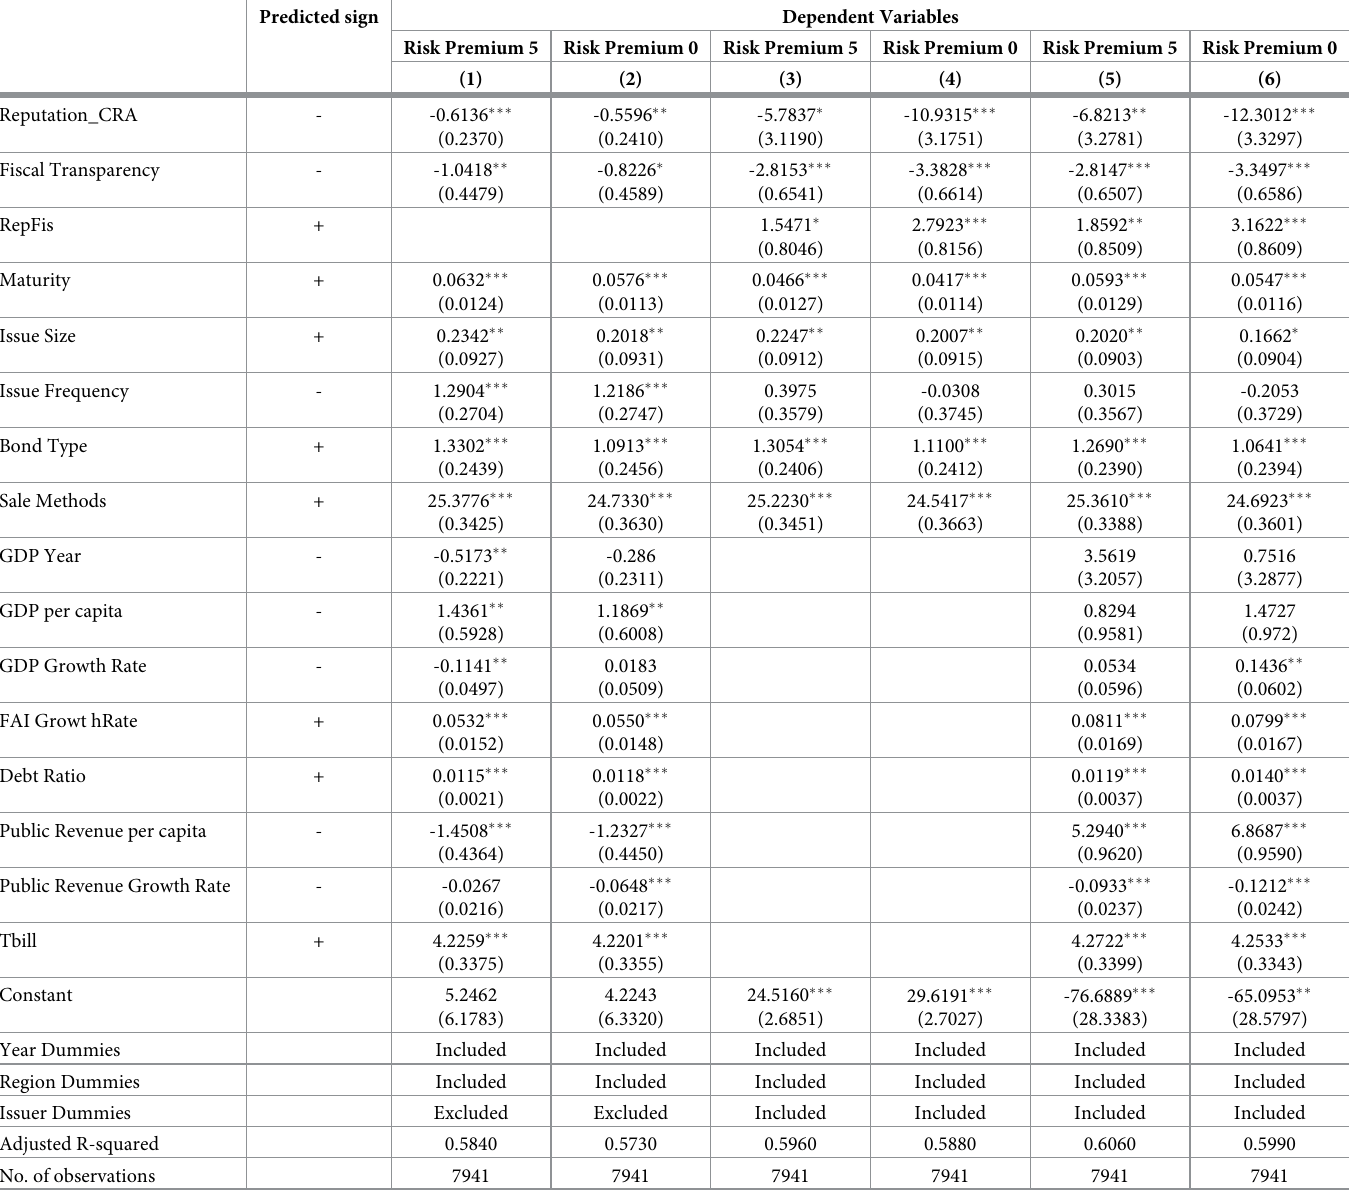
Table 8. Baseline regression results. This table reports the estimates of the baseline regression Eq (1). Predicted